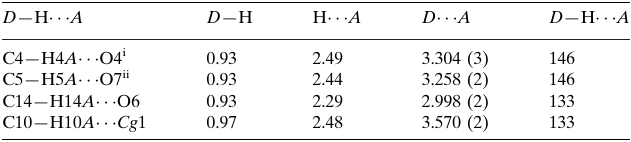
Hydrogen-bond geometry (A˚ , (cid:2) ). Cg 1 is the centroid of the C1–C6